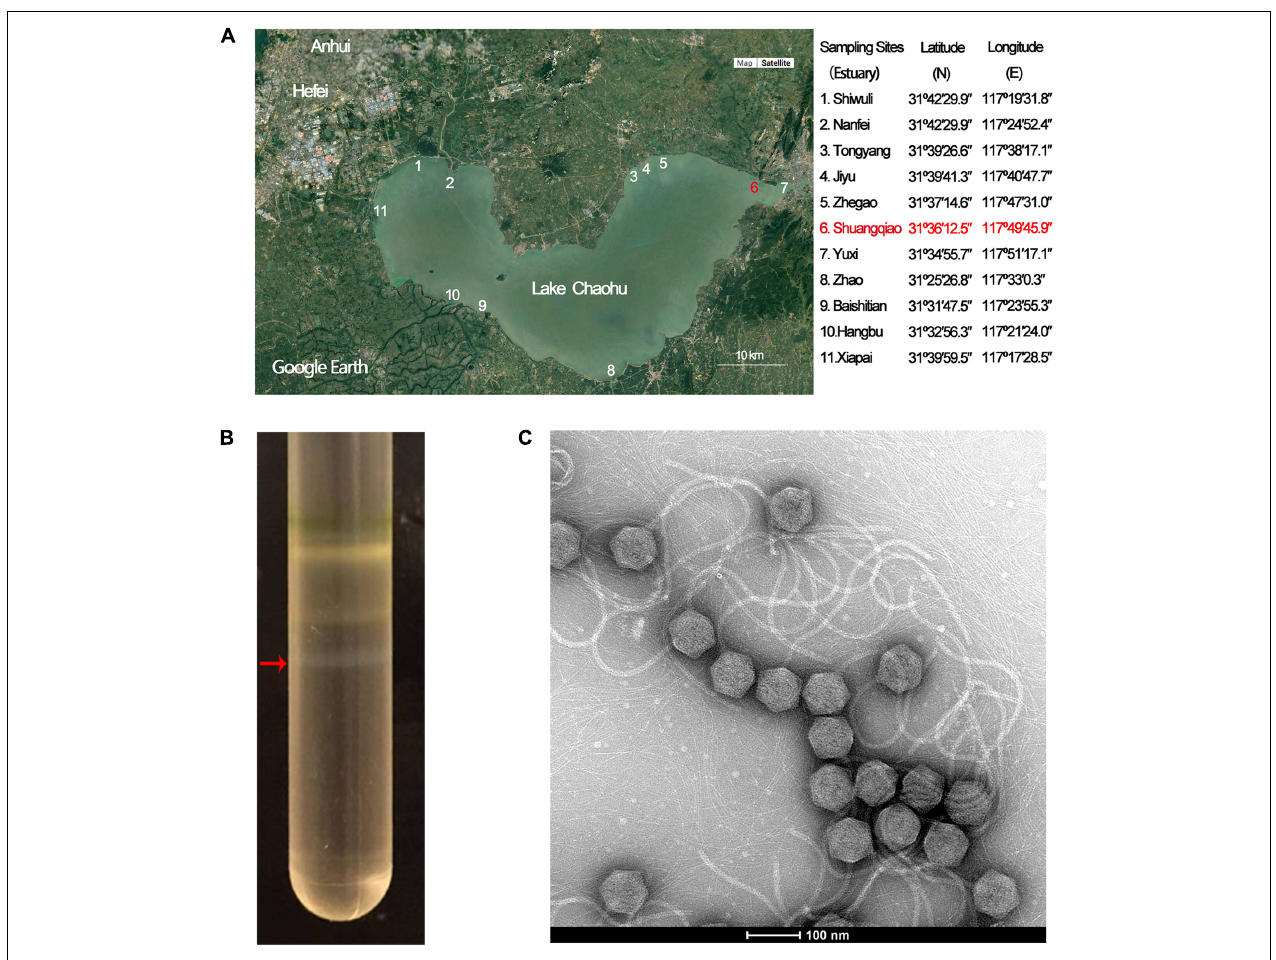
FIGURE 1 | Isolation, purification, and morphological identification of Mic1. (A) Location of Lake Chaohu (from the Google Earth) and the coordinates of 11 major river estuaries to Lake Chaohu. The red mark shows the site where Mic1 was isolated. (B) CsCl density gradient ultracentrifugation of Mic1. Mic1 concentrated in the fourth layer gradient is indicated by a red arrow. (C) Electron micrograph negatively stained Mic1 particles. The cyanophage Mic1 were negatively stained with uranyl acetate and visualized by transmission electron microscopy at 120 kV accelerating voltage. The phages have an isometric head of ∼ 88 nm in diameter and a long, non-contractile tail of ∼ 400 nm in